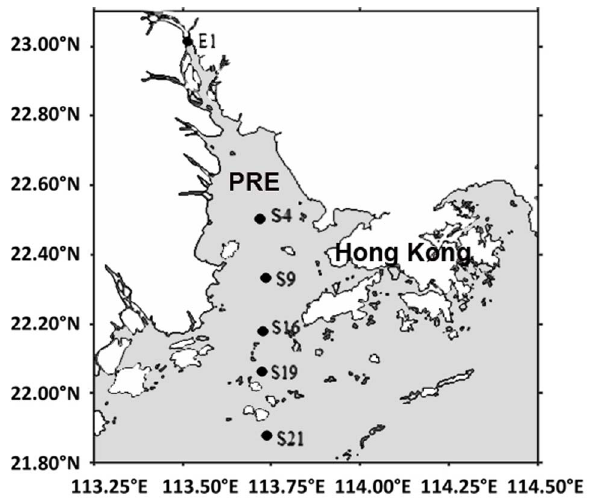
Figure 1. Maps showing the sampling stations. The surface sediment and its overlying bottom water were collected from 6 stations (E1, S4, S9, S16, S19 and S21) along a transect from the Pearl River Estuary (PRE) to the South China